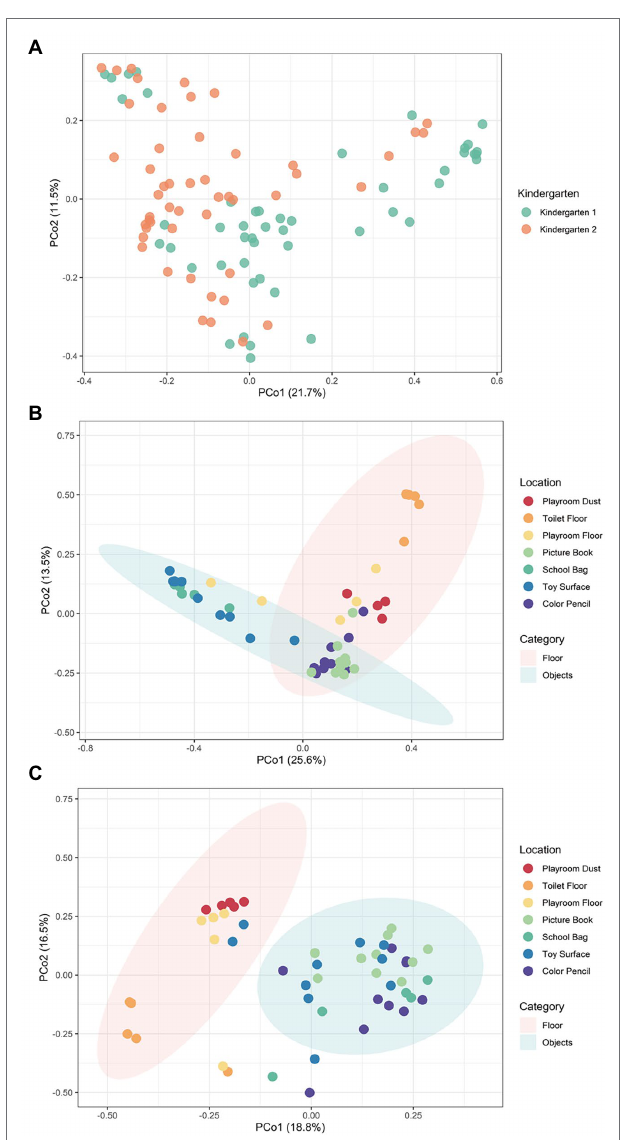
FIGURE 1 | The species-level microbial compositional profiles of the kindergartens visualized using the principal coordinate analysis (PCoA) based on Bray–Curtis distances. (A) The PCoA together for both kindergartens revealed significantly different compositions of microbial species (PERMANOVA; R 2 = 0.059, p < 0.001) between the two kindergartens. Moreover, individual PCoA was conducted separately for both (B) Kindergarten 1 and (C) Kindergarten 2, revealing significantly different composition of microbial species (kindergarten 1: PERMANOVA; R 2 = 0.467, p < 0.001, kindergarten 2: PERMANOVA; R 2 = 0.366, p < 0.001) between samples collected from the floor (Playroom Dust, Playroom Floor, and Toilet Floor), and those collected from hand-touched objects (Picture Book, School Bag, Toy Surface, and Color Pencil). Each point corresponds to a sample and is colored according to the kindergarten or sampling site. Ellipses correspond to 95% confidence